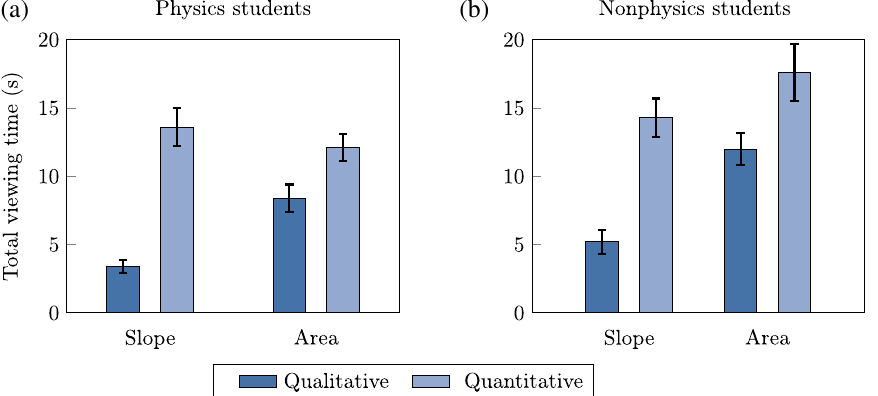
FIG. 12. Average confidence ratings of physics students (a) and nonphysics students (b) on the qualitative and quantitative questions about graph slope and area under a graph. The error bars represent 1 SEM.